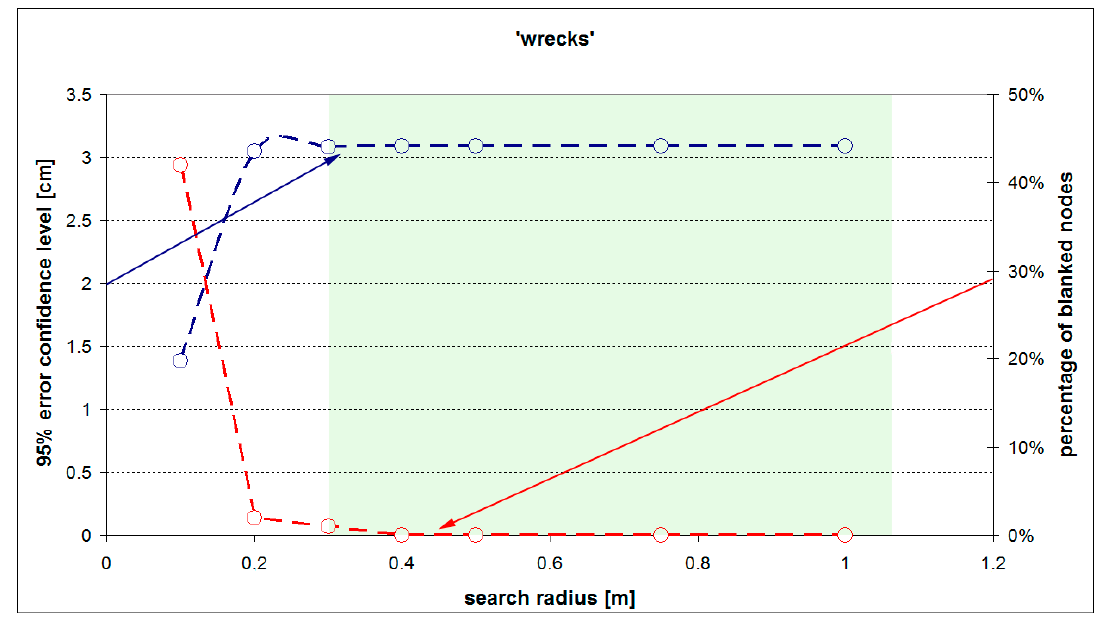
Figure 5. The results for ‘wrecks’ surface with different search radius values.